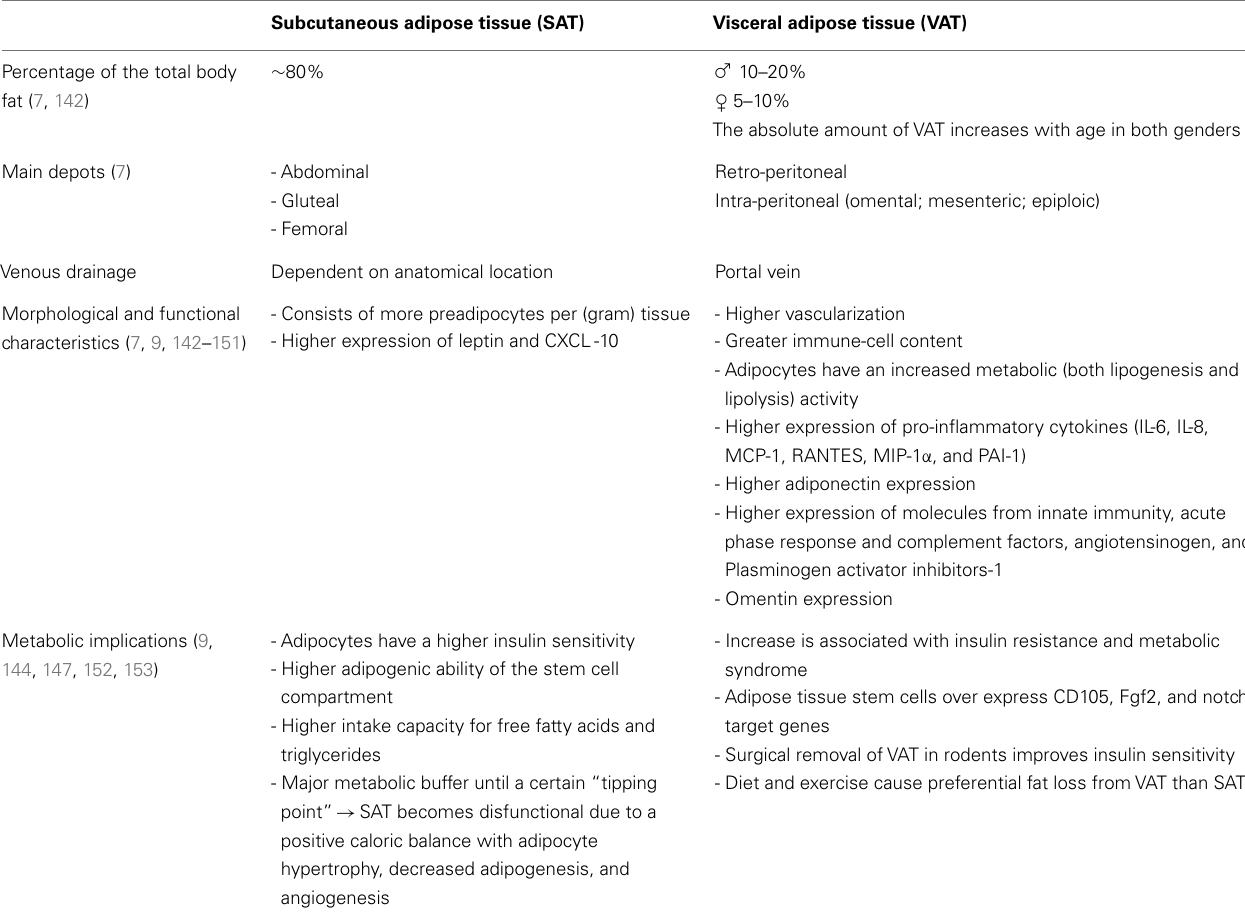
Table 1 |Adipose tissue depots